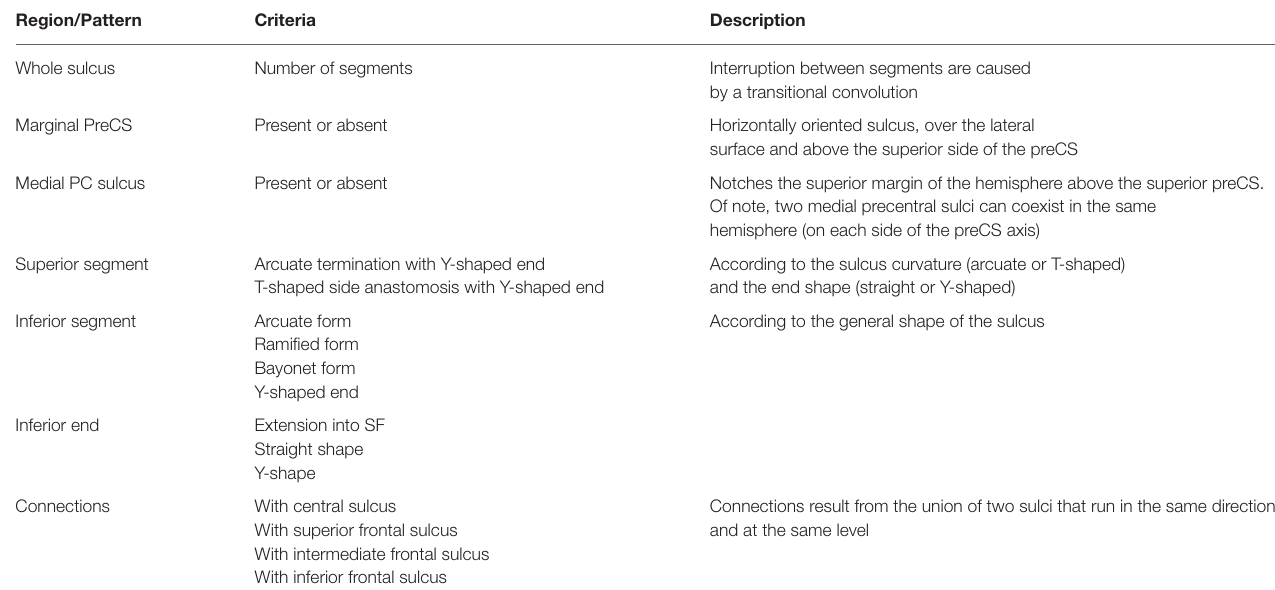
TABLE 2 | Description of the 18 criteria defining the pattern of the